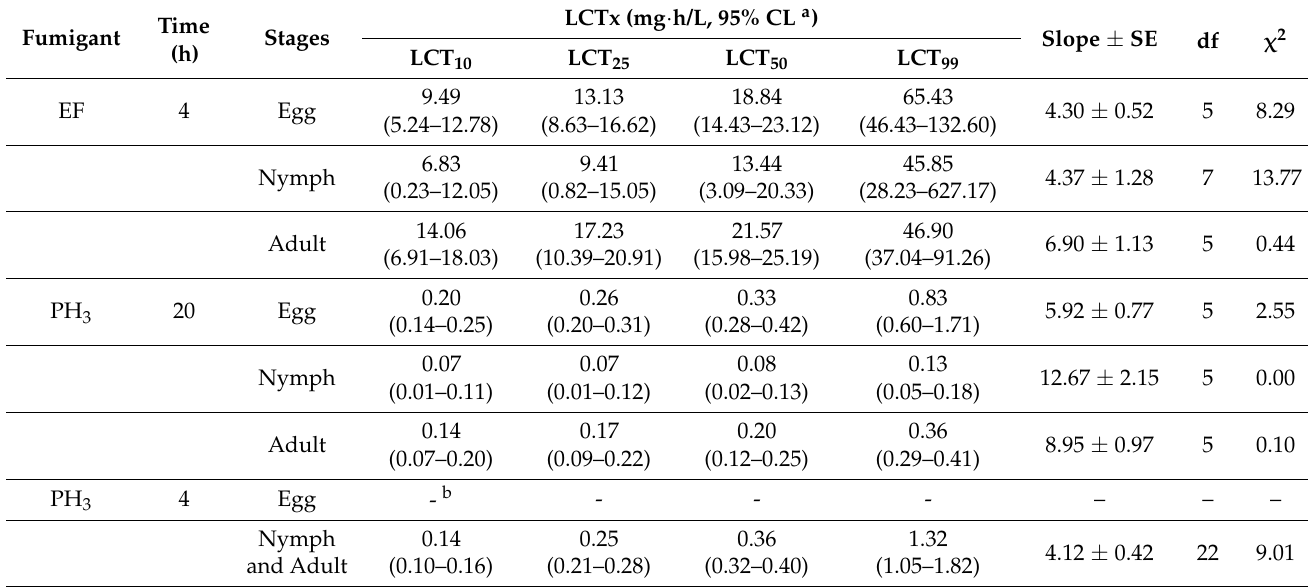
Table 1. Lethal concentration time (LCT) of P. citri in adult, nymph, and egg stages exposed to ethyl formate (EF) or